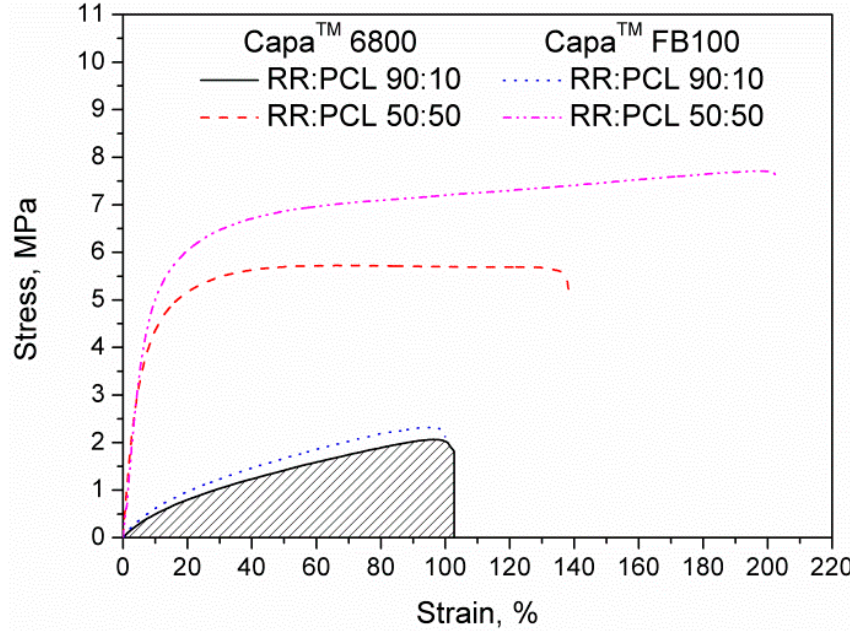
Figure 2. Stress–strain curves of RR/PCL blends. Table 3. Static and dynamic mechanical properties of RR/PCL blends.